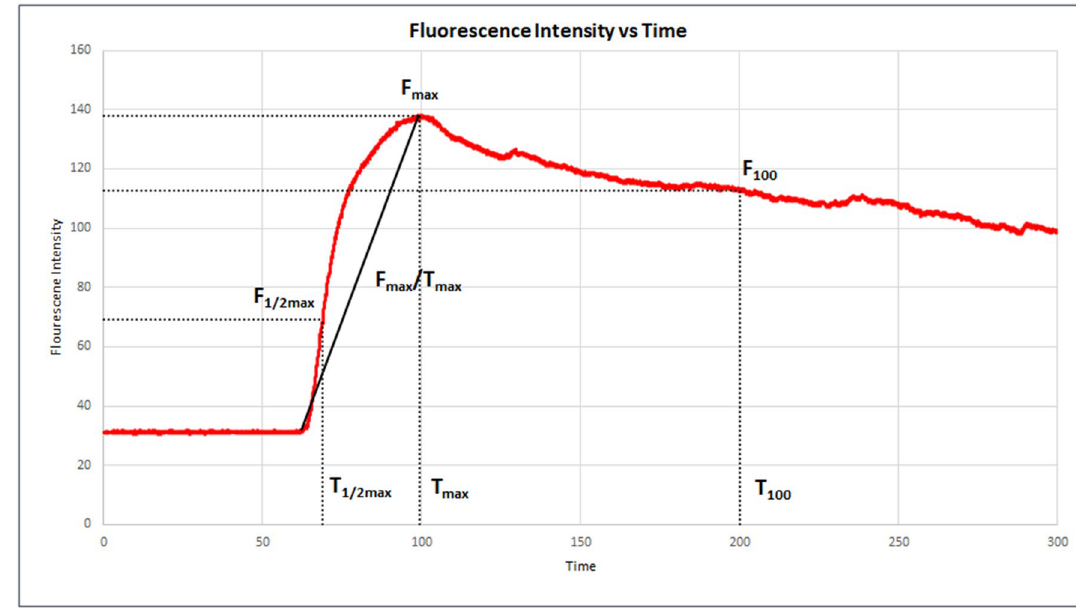
Figure 3. Representative graph (Microsoft Excel for Microsoft 365) of in vivo NIR intensity patterns plotting fluorescence intensity versus time to show the curve variables selected for statistical comparison between malignant, benign and normal tissue in videos from patients in this series. In vivo Dynamic video readings